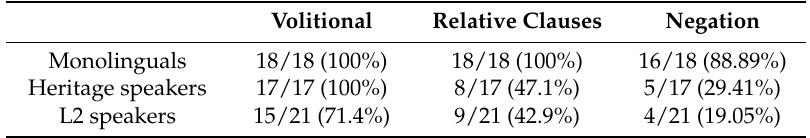
Table 2. Number of participants per group who produced subjunctive more than